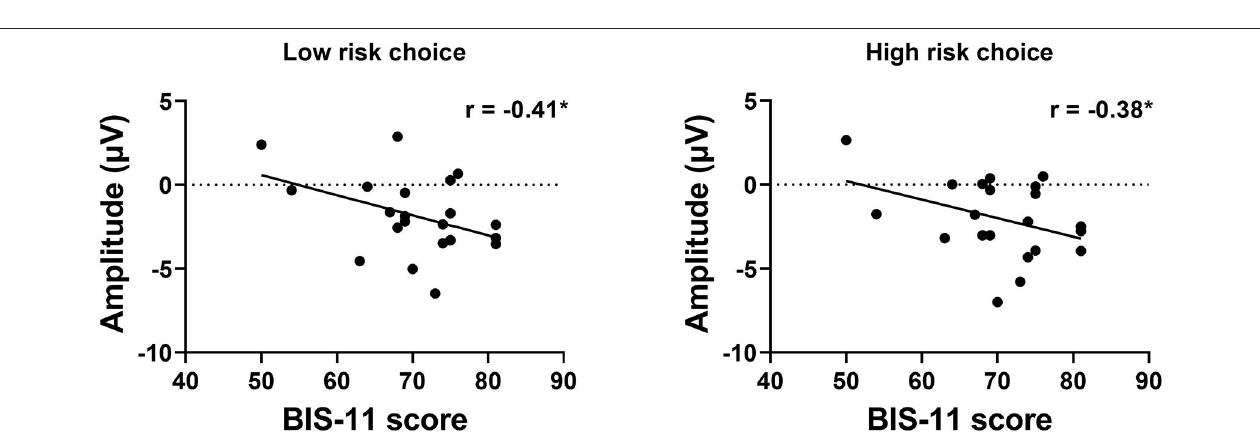
FIGURE 6 | Correlation between BIS score and the SPN amplitude. The left panel shows the result when choosing low risk choices, and the right panel shows the result when choosing high risk